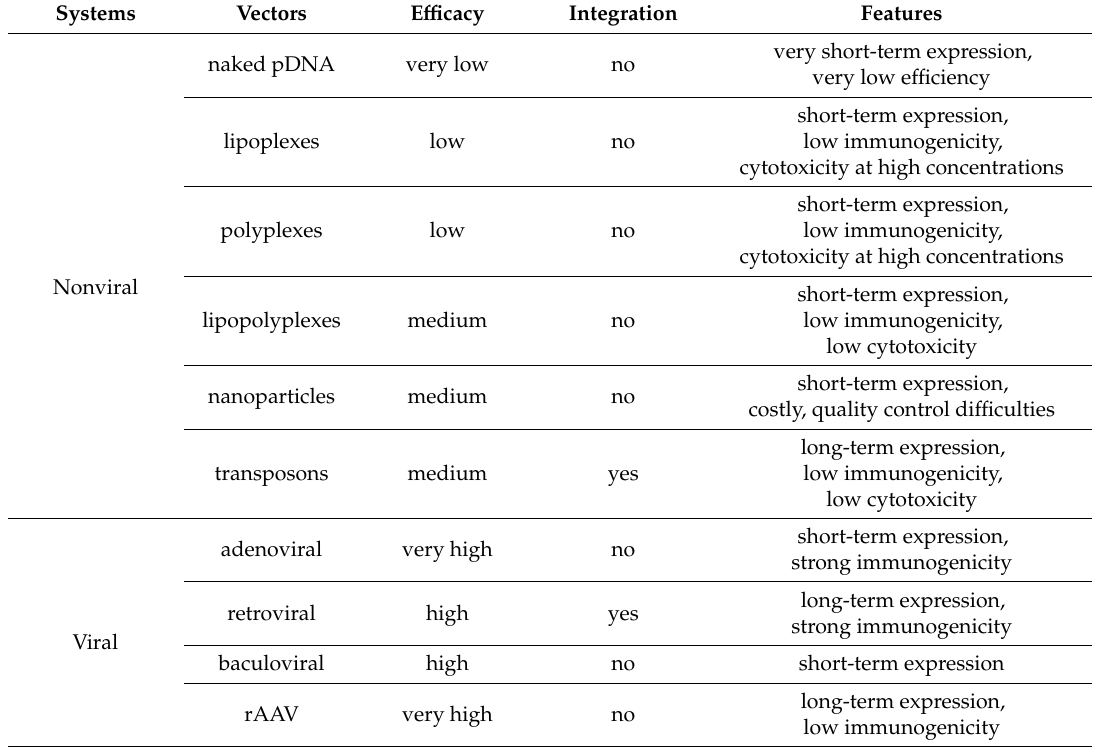
Table 1. Gene transfer